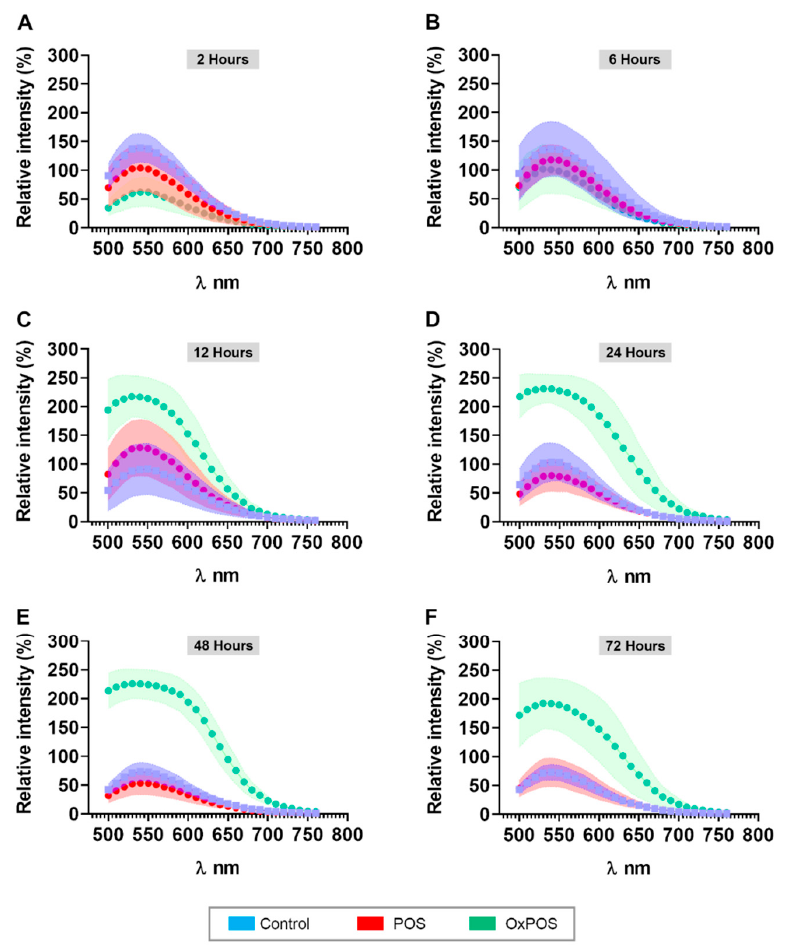
Figure 7. Autofluorescence readouts from POS and OxPOS-fed RPE cells as a function of time. In order to evaluate the spectral signature of RPE cells fed with POS or OxPOS, cultures were excited at 488 nm and lambda scans (emissions) collected at every 10 nm windows. The relative florescence intensity for control (no POS), POS- or OxPOS-fed cultures is shown between 500 and 750 nm for ( A ) 2 h, ( B ) 6 h, ( C ) 12 h, ( D ) 24 h, ( E ) 48 h and ( F ) 72 h, after the feeding assay. Although there were no obvious changes in the autofluorescence readouts at early time points, significant differences emerged between control and POS vs. OxPOS-fed cells after 12 h. Differences between OxPOS vs. POS and controls continued to grow with increasing time, reflecting the contrasting fates between these two cargos. Data from a minimum of n = 3 random images/per time point. Statistical studies were performed using a one-way ANOVA followed by Tukey’s multiple comparison tests. For ease of comparing, multiple errors bars between groups are indicated by a color-coded range on either side of the median value (also see Table S4). 3. Discussion Elevated proteolytic stress of RPE cells in the aging retina is an important mechanism of early damage which leads to eventual cellular atrophy, a key feature in several blinding conditions. The failure to degrade cargos effectively in a timely manner stems from the dysfunction in one or both of two systems which maintains proteostasis: the ubiquitin proteasome pathway and the autophagy- lysosomal degradation pathway. There is considerable overlap between these, which is not unexpected considering their inter-linked natures [4,6,39–41]. Recent evidence suggests that depending on circumstances, cells are able to favor one pathway over the other, including re- purposing or cannibalizing components from one system to boost activities of the other [42–45]. Analysis of healthy aged as well as diseased/AMD donor tissues indicate a contributory role and/or